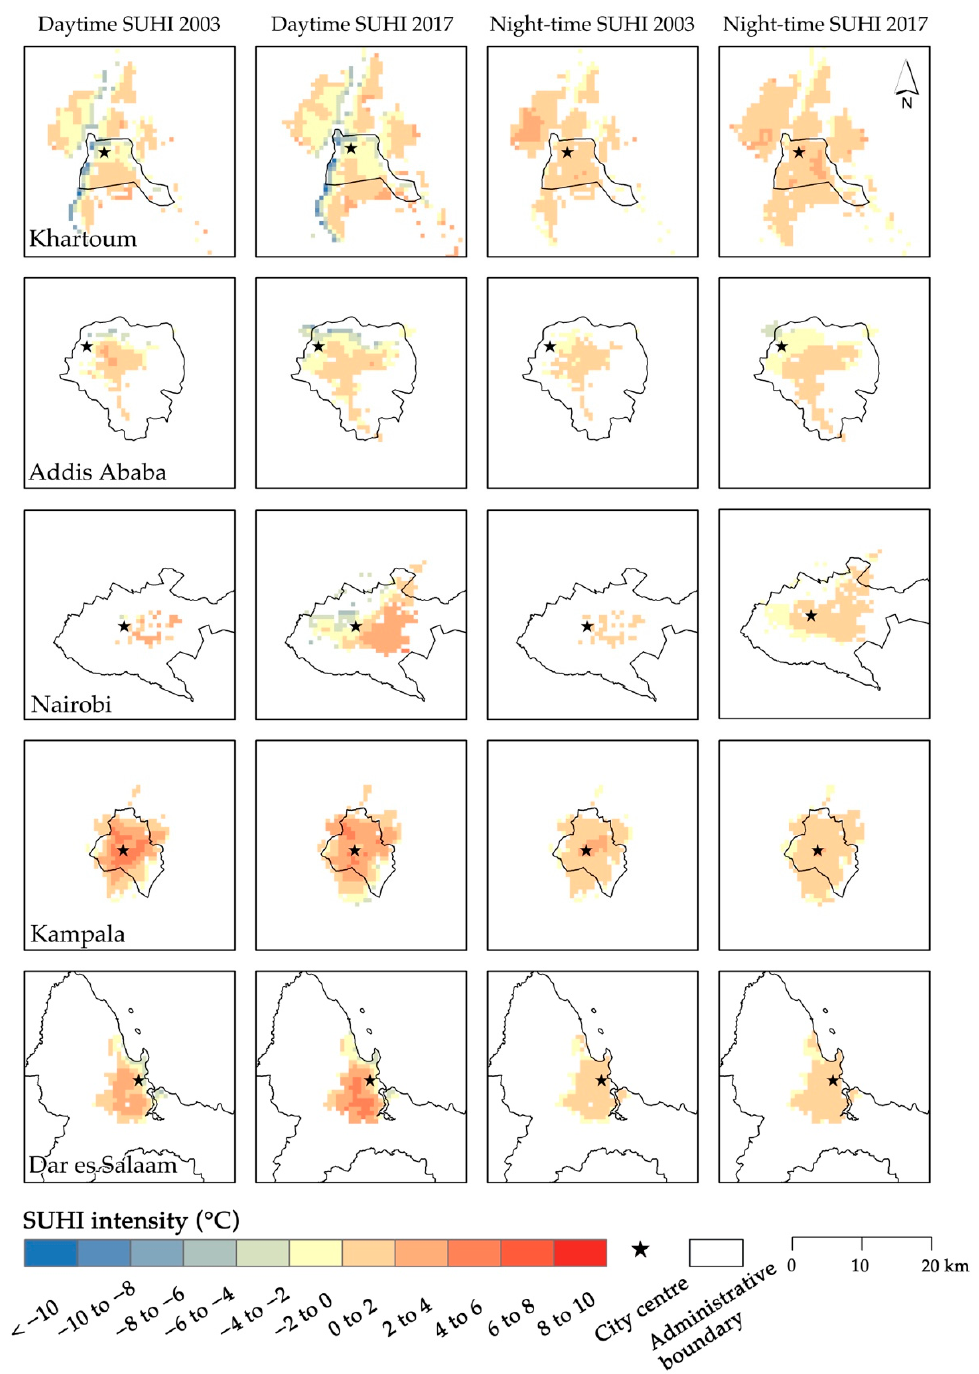
Figure 3. Daytime and night-time SUHI spatial distribution in each city in 2003 and 2017. Addis Ababa, Kampala, Nairobi and Dar es Salaam demonstrate positive daytime SUHI intensity in 2003 while Khartoum, located within the warm desert climate, was found to demonstrate a surface urban cool island (SUCI) effect. In 2017, Kampala, Nairobi and Dar es Salaam still demonstrate a positive daytime SUHI intensity, while Addis Ababa shows a SUCI, as does Khartoum. All cities had positive night-time SUHI in 2003. This was true in 2017, except for Addis Ababa. The urban areas located in the humid subtropical climate changed from displaying a SUHI to SUCI. In 2003 and 2017, Kampala presents the highest daytime SUHI intensity and Khartoum demonstrates the lowest daytime